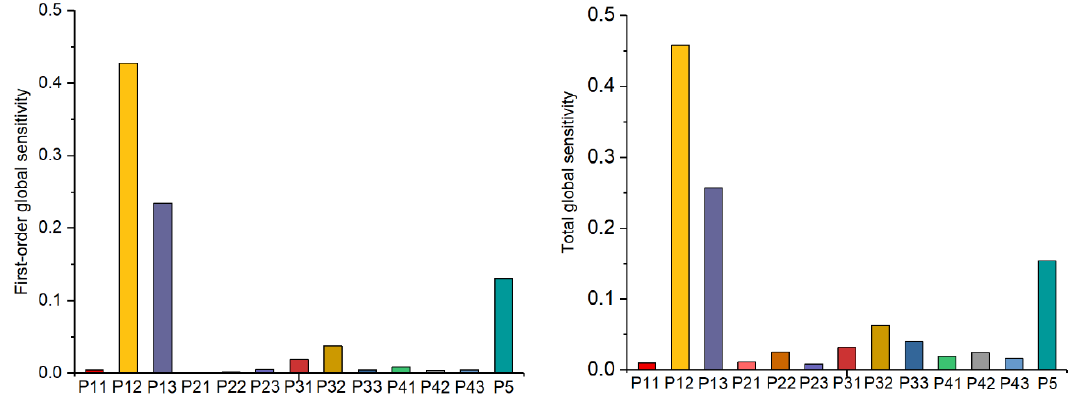
Figure 10. Histogram of sensitivity analysis